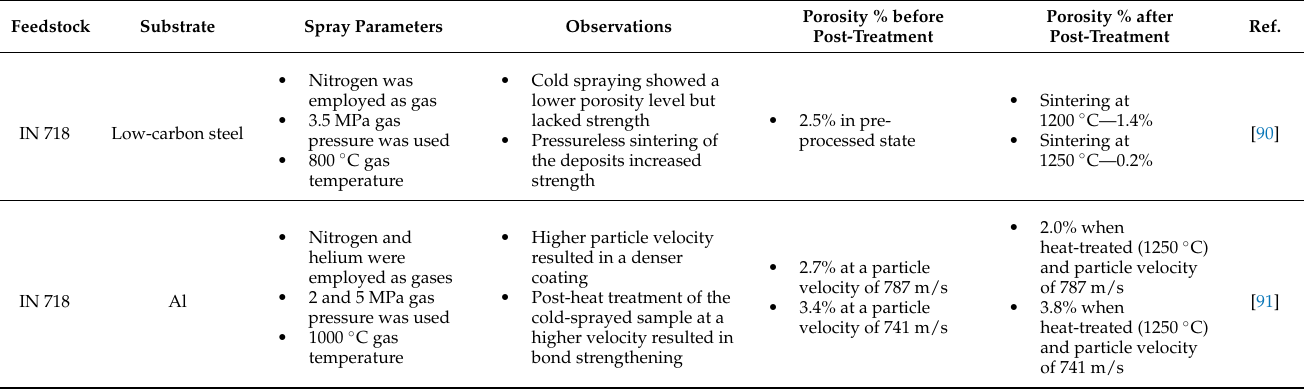
Figure 10. A schematic representation of the key operational and process parameters for CSAM Ni-based superalloys. Table 1. A summarization of the current literature on the structural and microstructural formation of CS-based Ni superalloys.